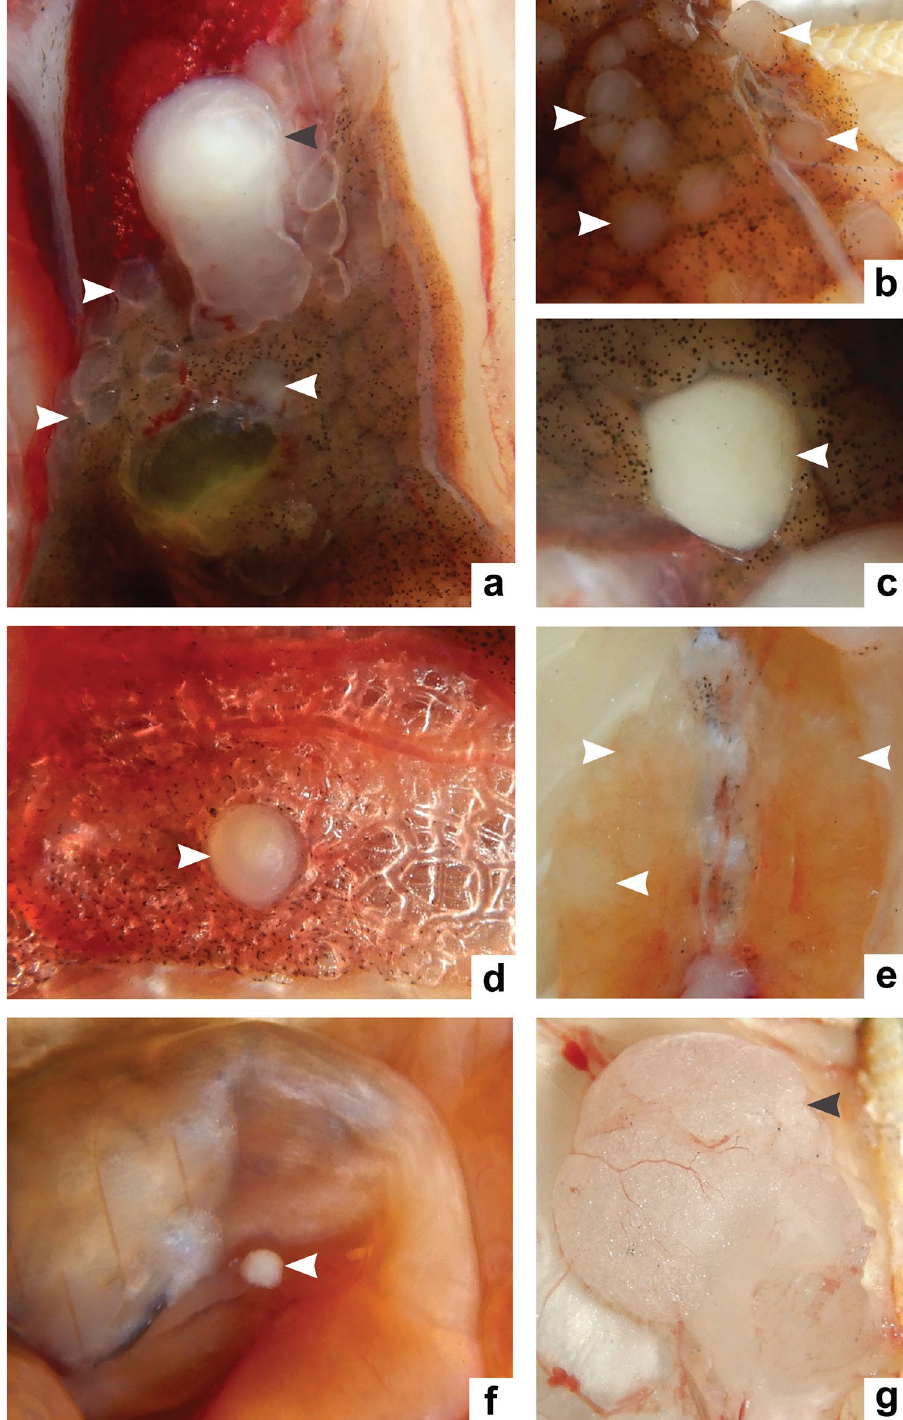
Figure 3. Macroscopic findings of Asian house geckos infected with E. lacertideformus . One large raised white focus adherent to the surface of the lung (grey arrowhead) and multiple smaller foci extending from the surface of the liver (white arrowheads) (gecko ID: CoC-4) ( a ), multifocal masses extensively replacing the hepatic parenchyma (white arrowheads) (gecko ID: SkL-2) ( b ), replacement of the gallbladder lumen with bacterial colonies (white arrowhead) (gecko ID: SuC-3) ( c ), a single raised white focus replacing parenchyma of the left lung and distending the pleura (white arrowhead) (gecko ID: NaI-9) ( d ), bilateral replacement of renal parenchyma by multiple raised white foci (white arrowheads) (gecko ID: SkL-2) ( e ), single raised white focus adhered to serosa of the lesser curvature of the stomach (white arrowhead) (gecko ID: SkL-2) ( f ), single large ventral mass cranial to pelvis (grey arrowhead) (gecko ID: CoC-3) ( g